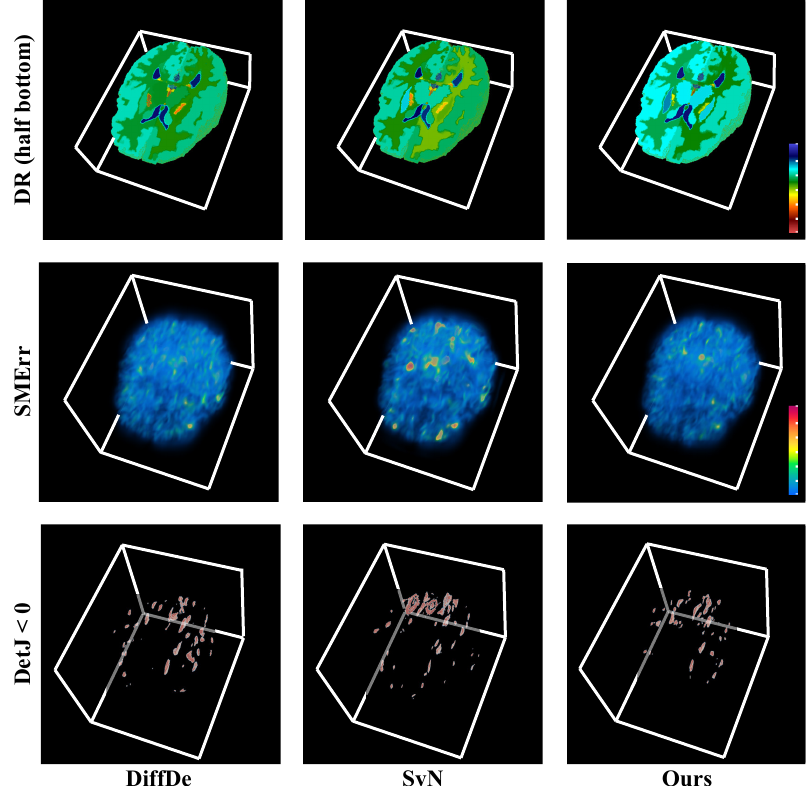
Figure 9. The qualitative results in Section 3.4, based on Figure 8, are shown. The first to third columns distinguish the results of DiffDe , SyN , and Ours . The first row displays the half-bottom volumetric plots of the DR , where the scale bar ranges from 0.7 to 0.91. The second row displays volumetric plots of the SMErr , where the scale bar ranges from 0 to 11.28. The third row displays the point cloud maps showing where the negative Jacobian determinant occurs (Det J <